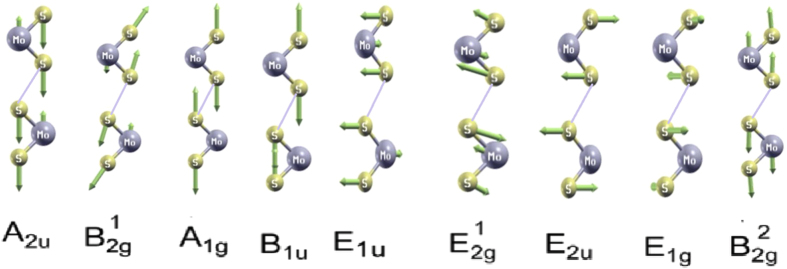
In-plane phonon modes  E2u, E1g and E1u and the out-of-plane phonon mode A2u,  A1g, B1u and B2g2 for the 3D flower type MoS2.